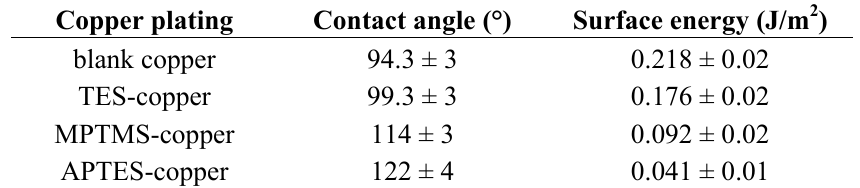
Table 2. Contact angle and surface energy of copper films on different SAMs.